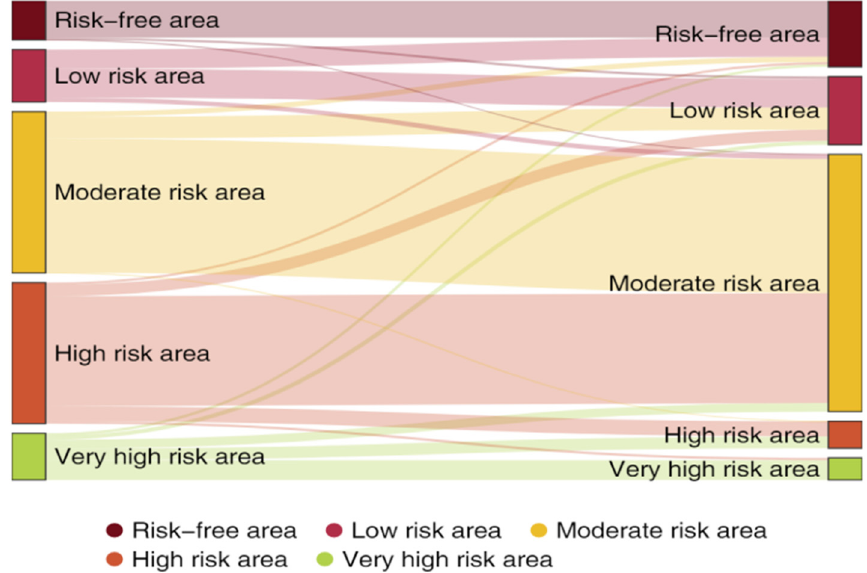
Figure 10. Salinization risk transfer diagram.